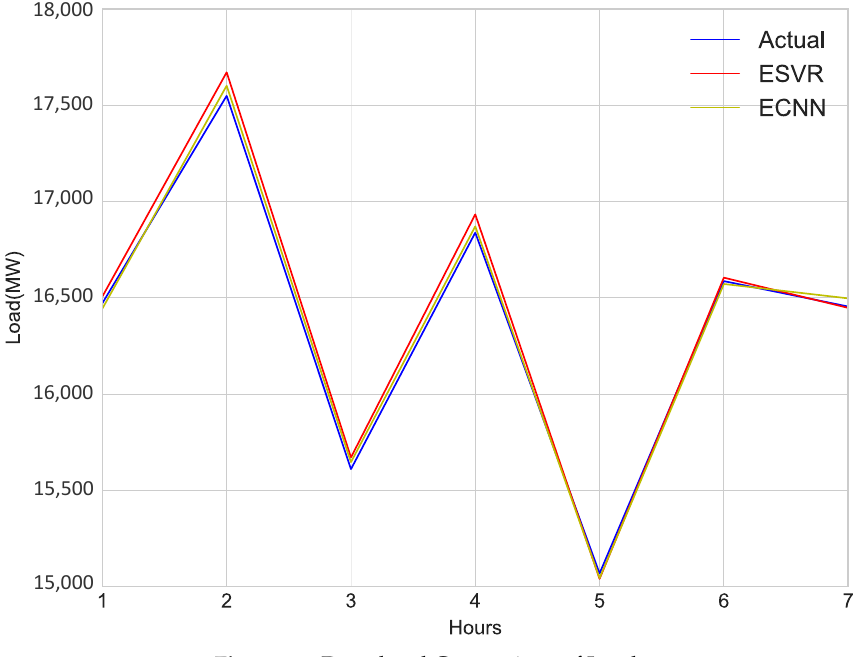
Figure 11. Day ahead Comparison of Load. Table 6. Performance Evaluation Metrics for Price Prediction